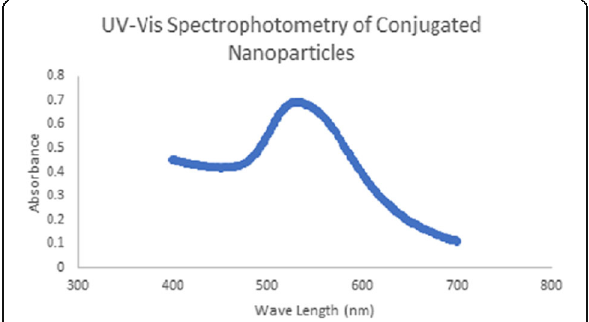
Fig. 5 Uv-Vis spectrophotometer absorbance spectrum of the Au- CSCaCO 3 NPs as discussed in the text